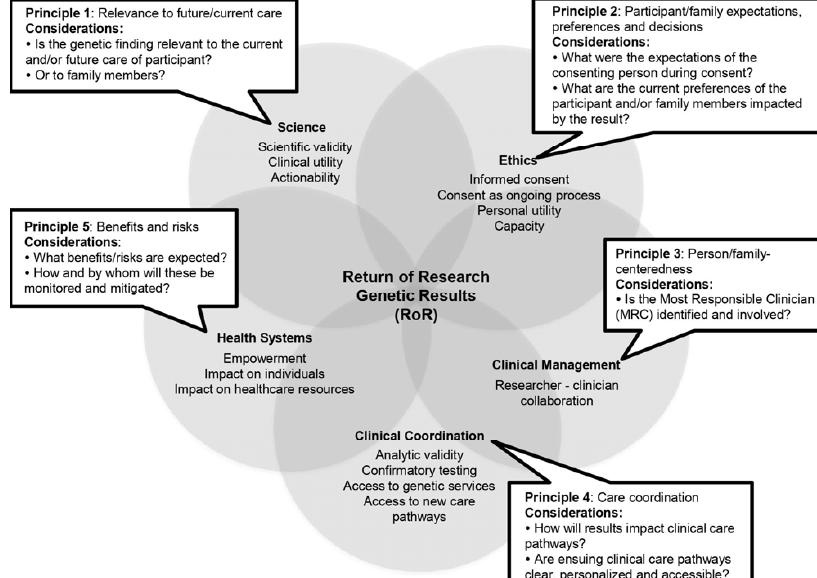
Figure 1. Summary of the proposed RoR framework, its principles, and their alignment within ethical, scientific, and healthcare domains. We offer a framework for RoR of actionable genetic research results that can guide research teams on specific points they should consider during the RoR process, with the aim of integration of genetic research results into the routine care of participants. The RoR framework was created through an iterative process that included review of the existing literature on topics related to RoR and review of real-life cases necessitating RoR from genetic research by a multi- disciplinary expert work group at our center. The proposed RoR framework entails five guiding principles that are centered within ethical, scientific, clinical management, clinical coordination and health system aspects of RoR. Within each of these domains, we highlight specific topics identified in the existing RoR literature that merit consideration by research teams engaged in RoR. We suggest that optimal use of genetic research results relies on their integration into individualized care pathways for participants.